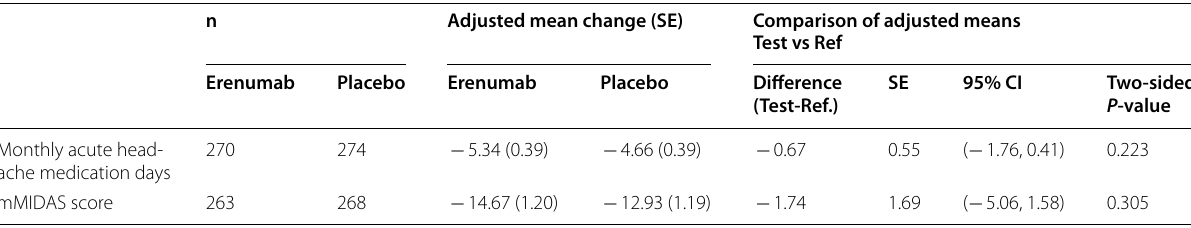
Table 2 Change from baseline to Week 12 in monthly acute headache medication days and migraine related disability and productivity as measured by the modified migraine disability assessment (mMIDAS)